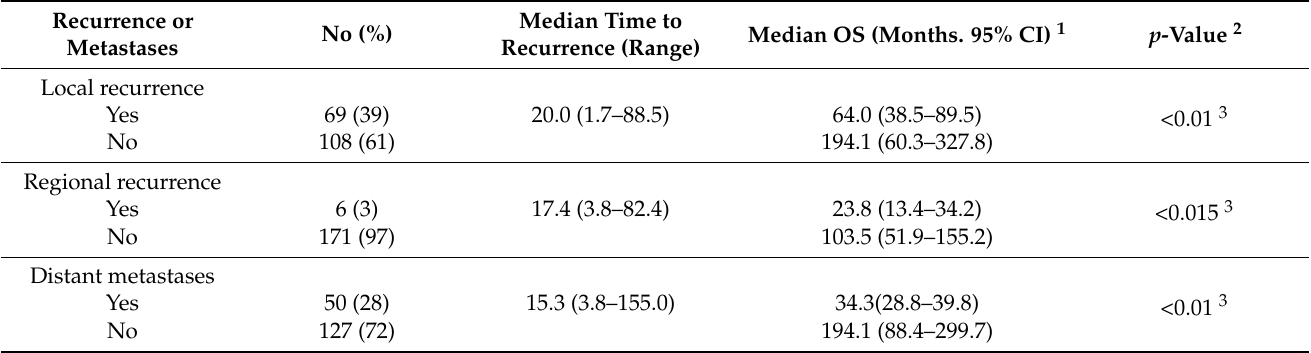
Table 2. Recurrence time and effect of recurrences and distant metastasis on overall survival.